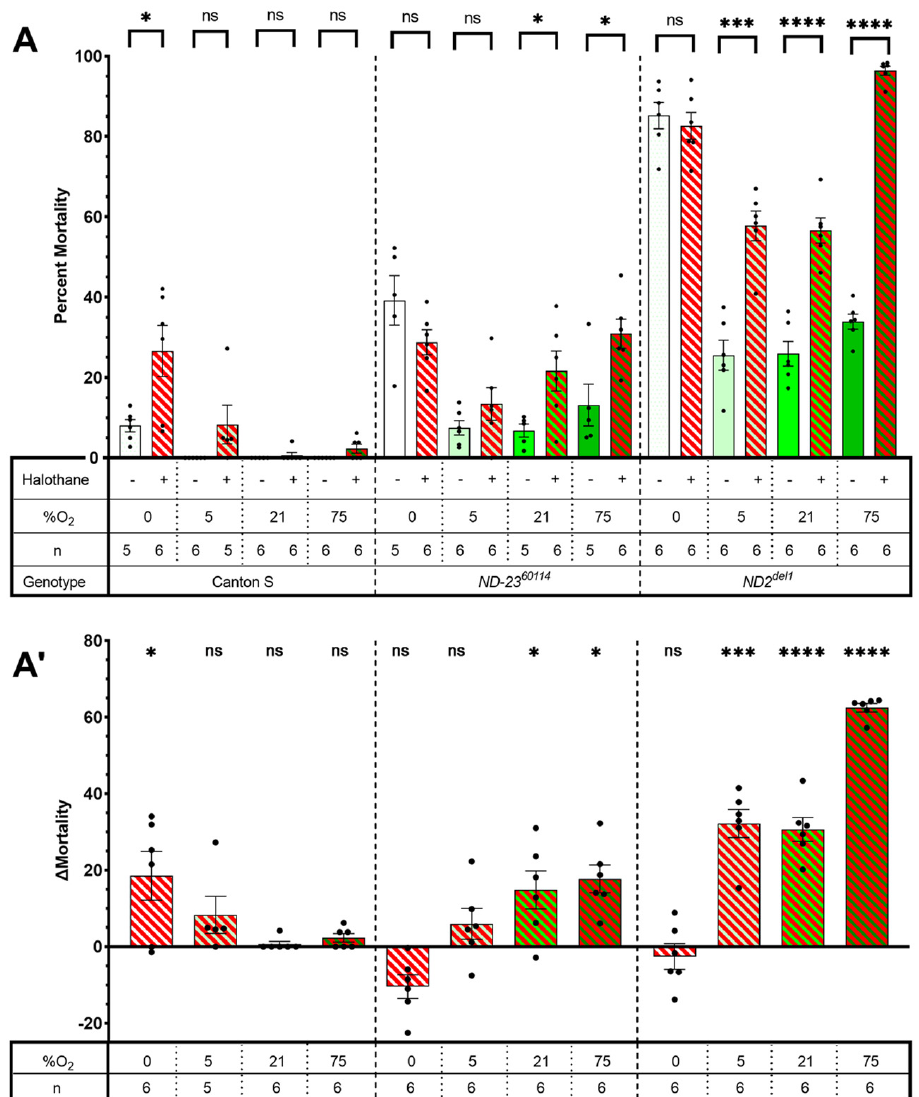
Figure 1. Halothane causes AiN in mitochondrial mutants. Flies of three genotypes at 11 to 13 days of age were exposed to two hours of 1.5% HAL administered by a carrier gas containing between zero and 75% O 2 and corresponding concentrations of N 2 . The number of dead flies was counted 24 h after exposure. Panel ( A ) shows the percent mortality under the various conditions while panel ( A’ ) shows the difference in percent mortality between flies exposed to halothane and those exposed to O 2 alone. Data shown as mean ± SEM, n indicates number of biological replicates of 25–30 mixed-sex flies contained in a single conical 50 mL tube, each shown as dots. ns: not significant, *: p < 0.05, ***: p < 0.001, ****: p < 0.0001. Note: high rates of natural attrition in mutants.